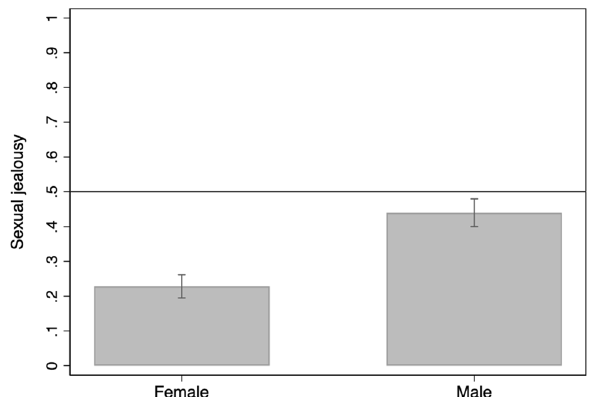
Figure 1. Proportion of female and male students (95% CIs) reporting being more upset by the sexual aspect of the infidelity on Scenario 1. Scores above solid line indicate being more upset by the sexual aspect of the infidelity scenario.